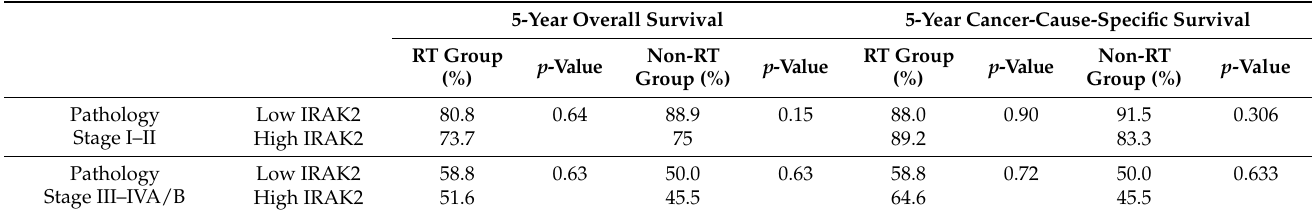
Table 4. Comparison of 5-year overall and cancer-cause-specific survival in correlation with pathology stage and expression level of